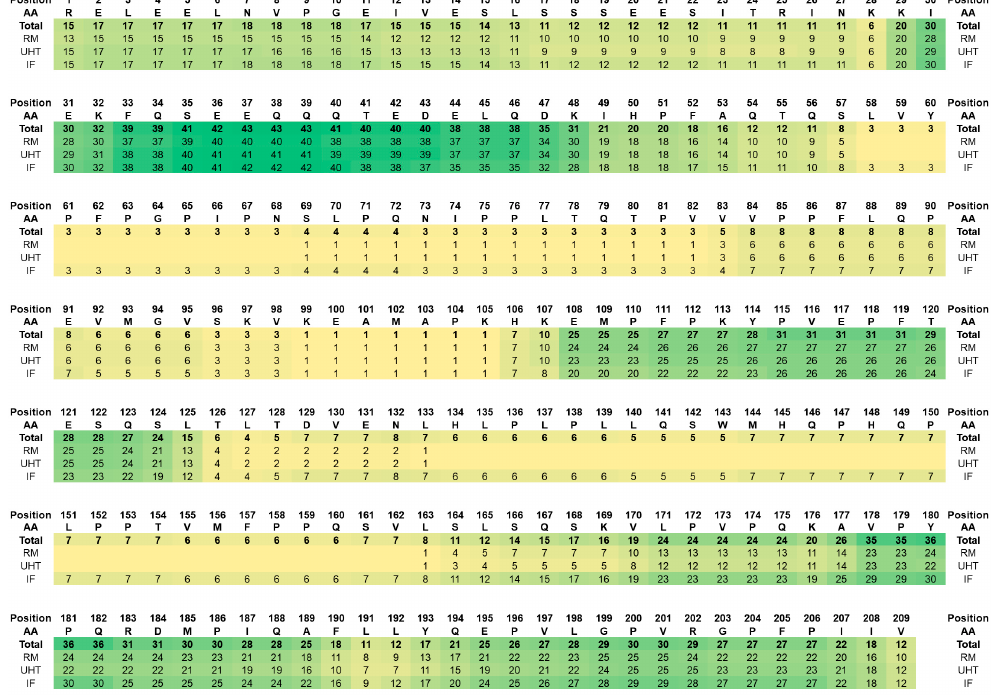
Figure 2. Protein sequence of β -casein without the signal peptide. The numbers below the sequence indicate how many peptides containing this specific residue were detected over all samples (total) and in RM (sequence coverage 80.9%), UHT milk (sequence coverage 80.9%), and IF (sequence coverage 100%). AA denotes amino acid.